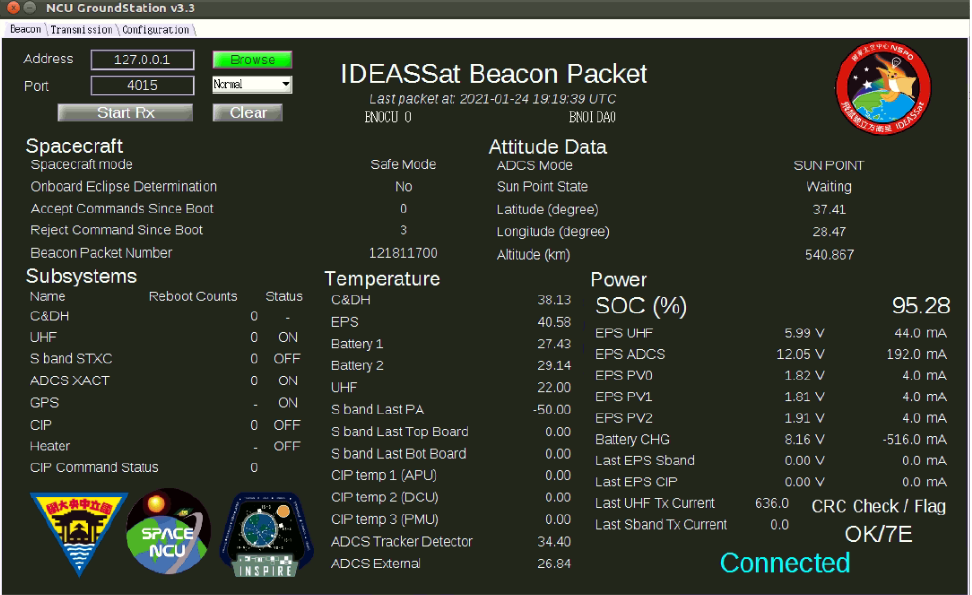
Figure 17. The first IDEASSat beacon packet received at approximately T + 4 hours after launch.